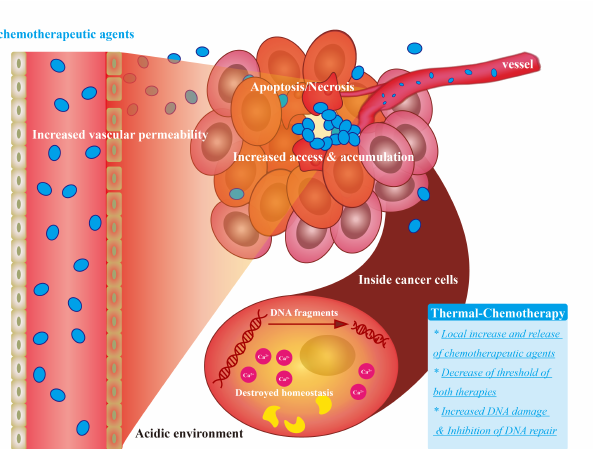
Figure 2. The mechanism of synergetic thermal therapy and chemotherapy. Other than induced cellu- lar apoptosis and necrosis, thermal energy increased the tumor vascular permeability, thus increasing delivery of the chemotherapeutic agents in the heated region and increasing local drug accumula- tion. Heating also changes the homeostasis of cancer cells, increases drug-induced DNA damage, and inhibits the repair of DNA, which lead to the decreased lethal threshold of both modalities.